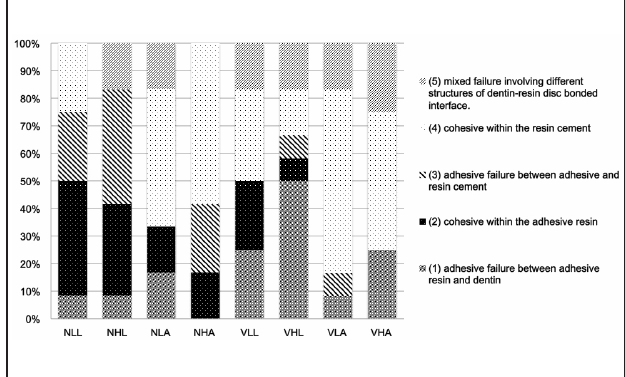
Fig. 1. Distribution (%) of failure modes among experimental